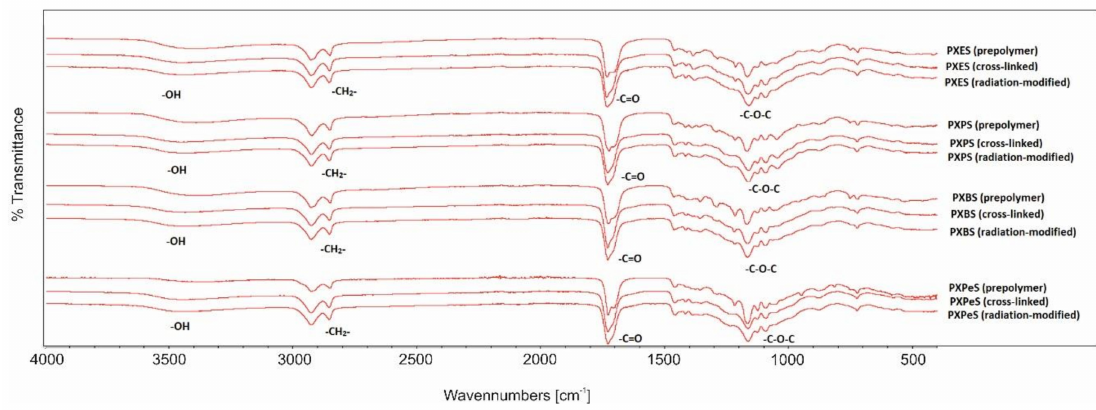
Figure 7. FTIR spectra of PXES, PXPS, PXBS, prepolymers, cross-linked polymers, and radiation-modified